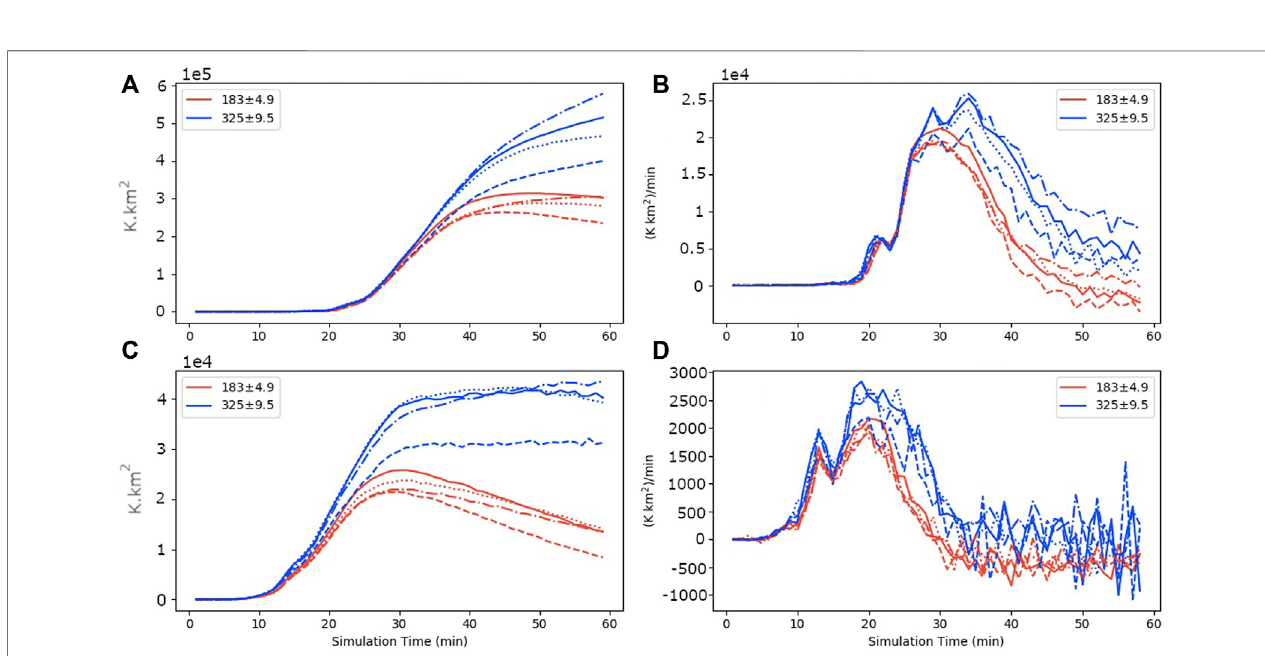
FIGURE3| Timeseries ofminimum brightnesstemperature (Tb min in K,subplots (A,C) and its time derivative (dTb min /dt inK/min, subplots (B,D) ;note thechange intimescale)fortheC3(183±2.8 GHzinred)andC8(325±3.5 GHzinblue)SAPHIR-NGchannels.Therightpanelsaretemporalzoomsoftheleftpanels,coveringthe period in grey shadings. Top row: strong convection; bottom row: weak convection. The line styles indicate the microphysics perturbation experiments (see Figure 2 ).